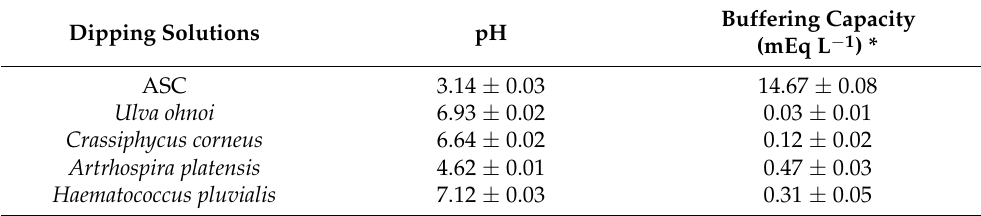
Table 2. Values of pH and buffering capacity measured for the aqueous dipping solutions (0.3% w/v ).